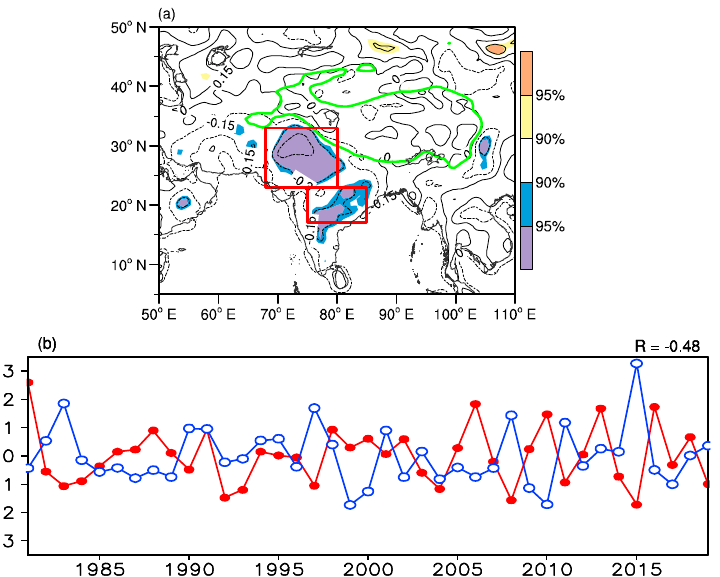
Figure 3. ( a ) Distribution of correlation coefficients between the summer eastern TP SAT index and April soil moisture (SM) during the period 1981–2019. Red boxes represent the Indian region (23° N–33° N, 68° E–80° E; 17° N–23° N, 75° E–85° E), which is the key region to define the Indian SM index. Contours are drawn every 0.15. The solid and dash lines denote positive and negative values, respectively. Shadings denote the correlation significant at the 90% and 95% confidence levels as shown by the color bars. ( b ) Standardized time series of the summer eastern TP SAT (red line) and April Indian SM index (blue